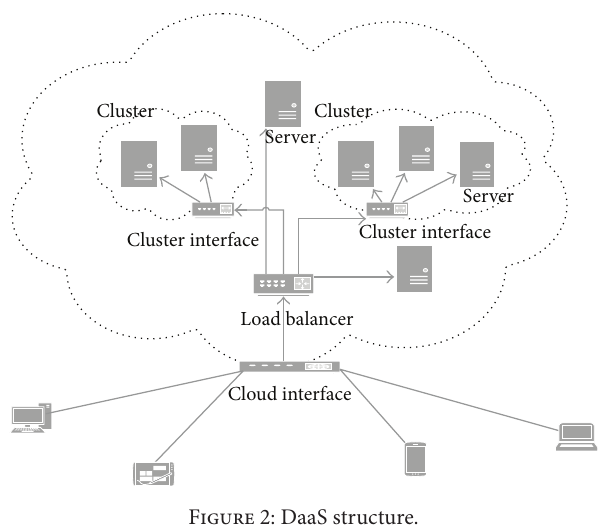
Figure 2: DaaS structure.